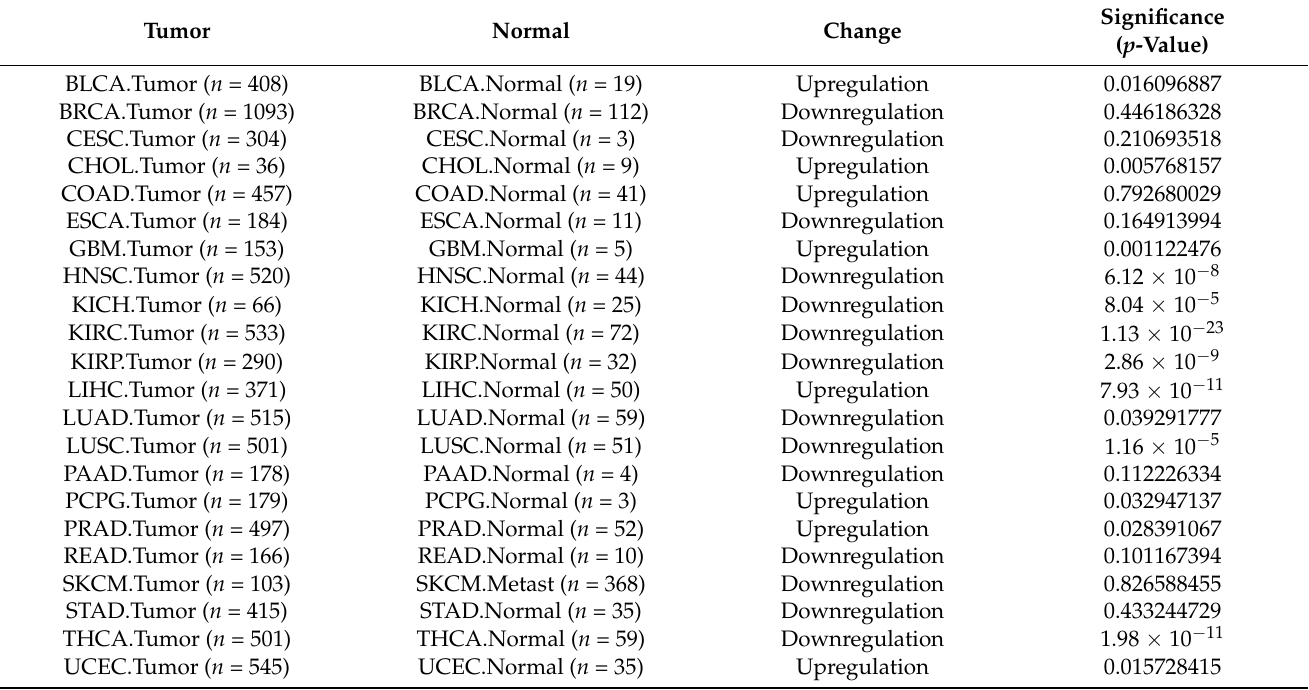
Table 3. Expression profile of ZNF433 in different cancers. Statistical significance was set at p <